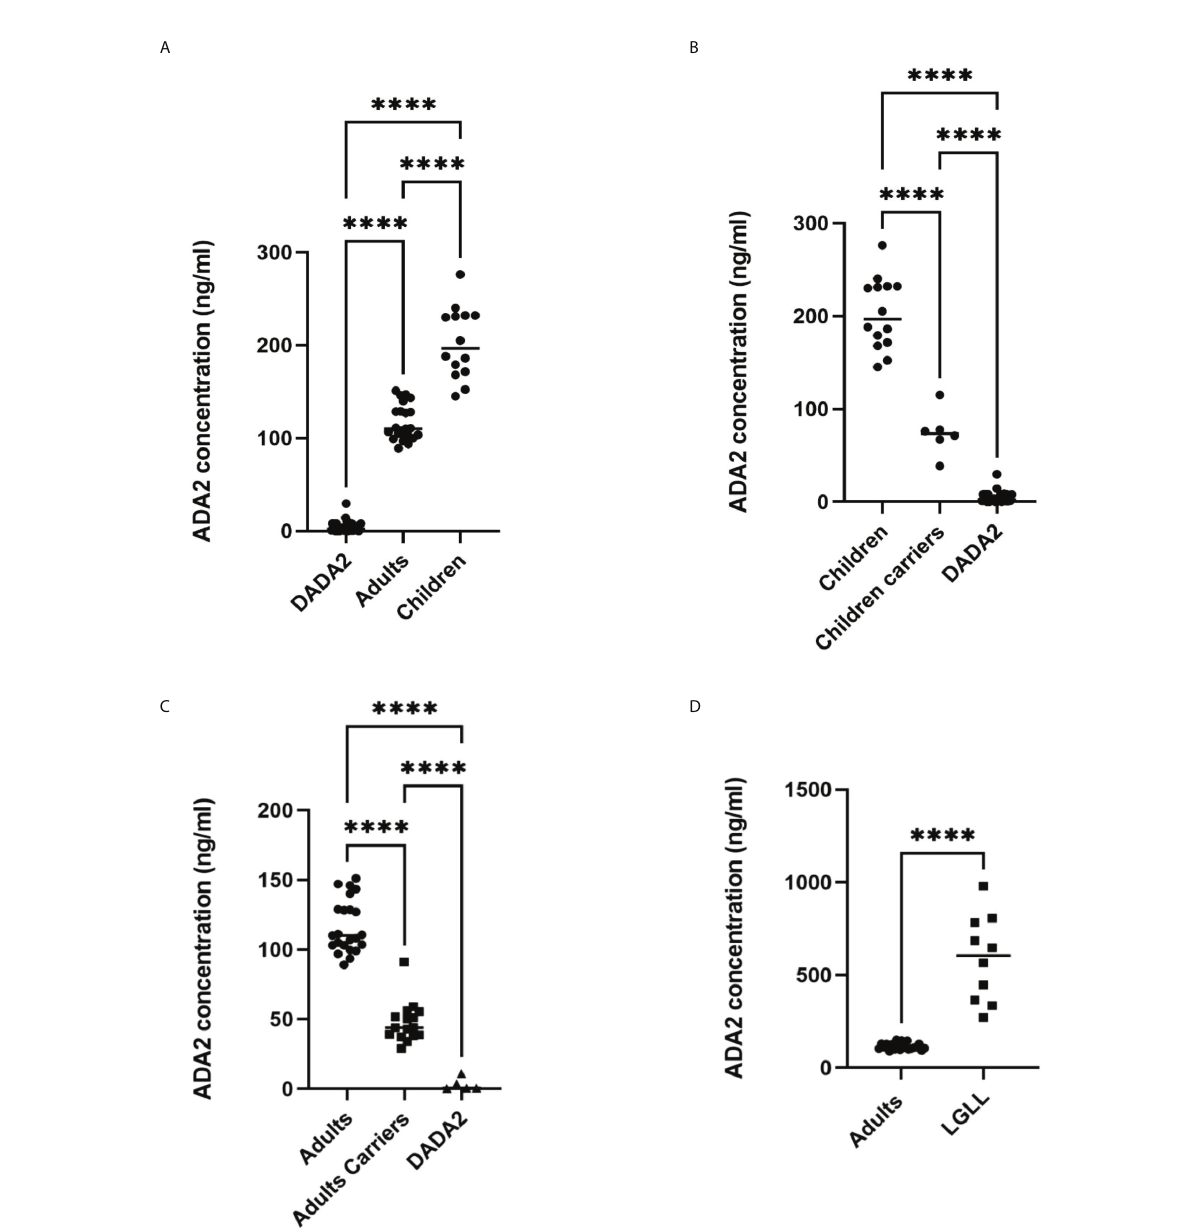
FIGURE 3 Analysis of ADA2 in serum of healthy donors and DADA2 patients using the method described in Figure 1A. (A) ADA2 concentration in serum samples from 14 healthy children, 23 healthy adults, and 32 DADA2 patients. (B) ADA2 concentration in serum samples from 14 healthy children, 6 children carriers, and 27 children DADA2 patients. (C) ADA2 concentration in serum samples from 23 healthy adults, 16 adults carriers, and 5 adult DADA2 patients. (D) ADA2 concentration in serum samples from 23 healthy adults and 10 LGLL patients. ****p<0.0001 according to one- way ANOVA test (A – C) or unpaired t-test (D)